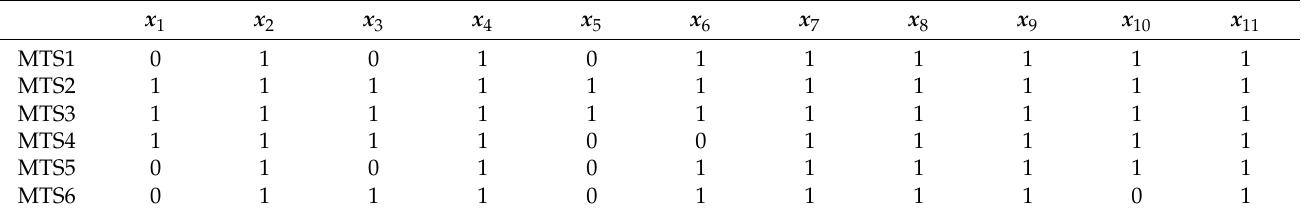
Table 8. Feature variable selection results of BT-MTS of the Wine quality-white data set.